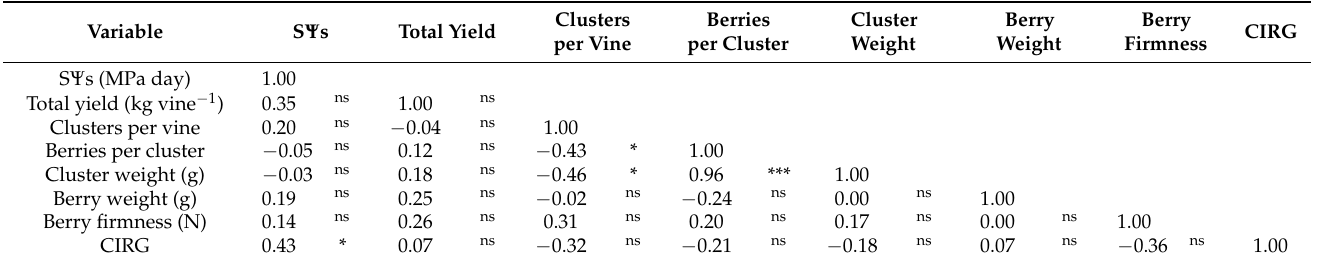
Table 3. Correlation matrix r-Pearson of the productive and quality variables on ‘Crimson Seedless’ vines under different water stress intensities during